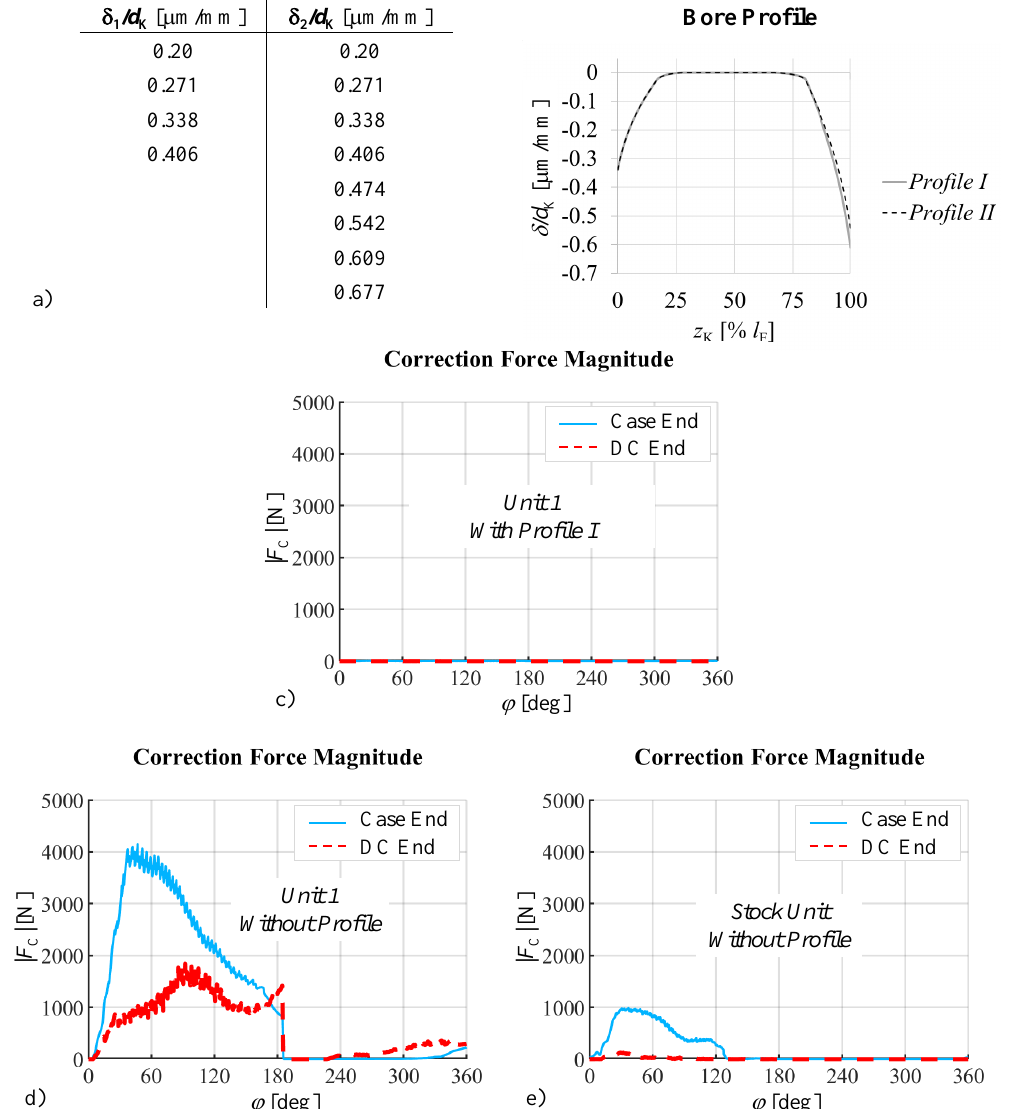
Figure 18. ( a ) TPGA inputs; ( b ) TPGA bore profile; and ( c – e ) simulation results for p LP = 2.5 bar, p HP = 120 bar, a pump speed of 700 rpm, and an inlet temperature of 20